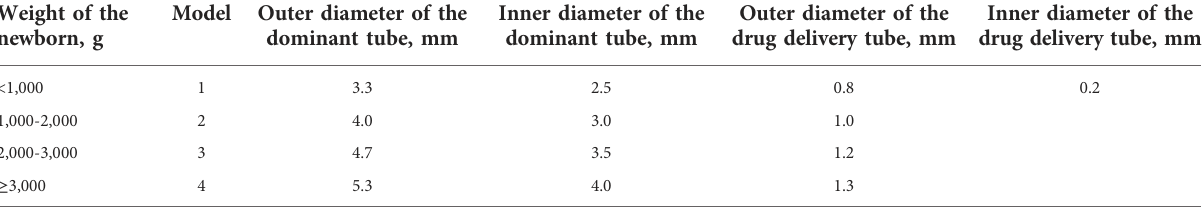
TABLE 1 Selection criteria for the diameter of the tracheal tube. Weight of the newborn, g